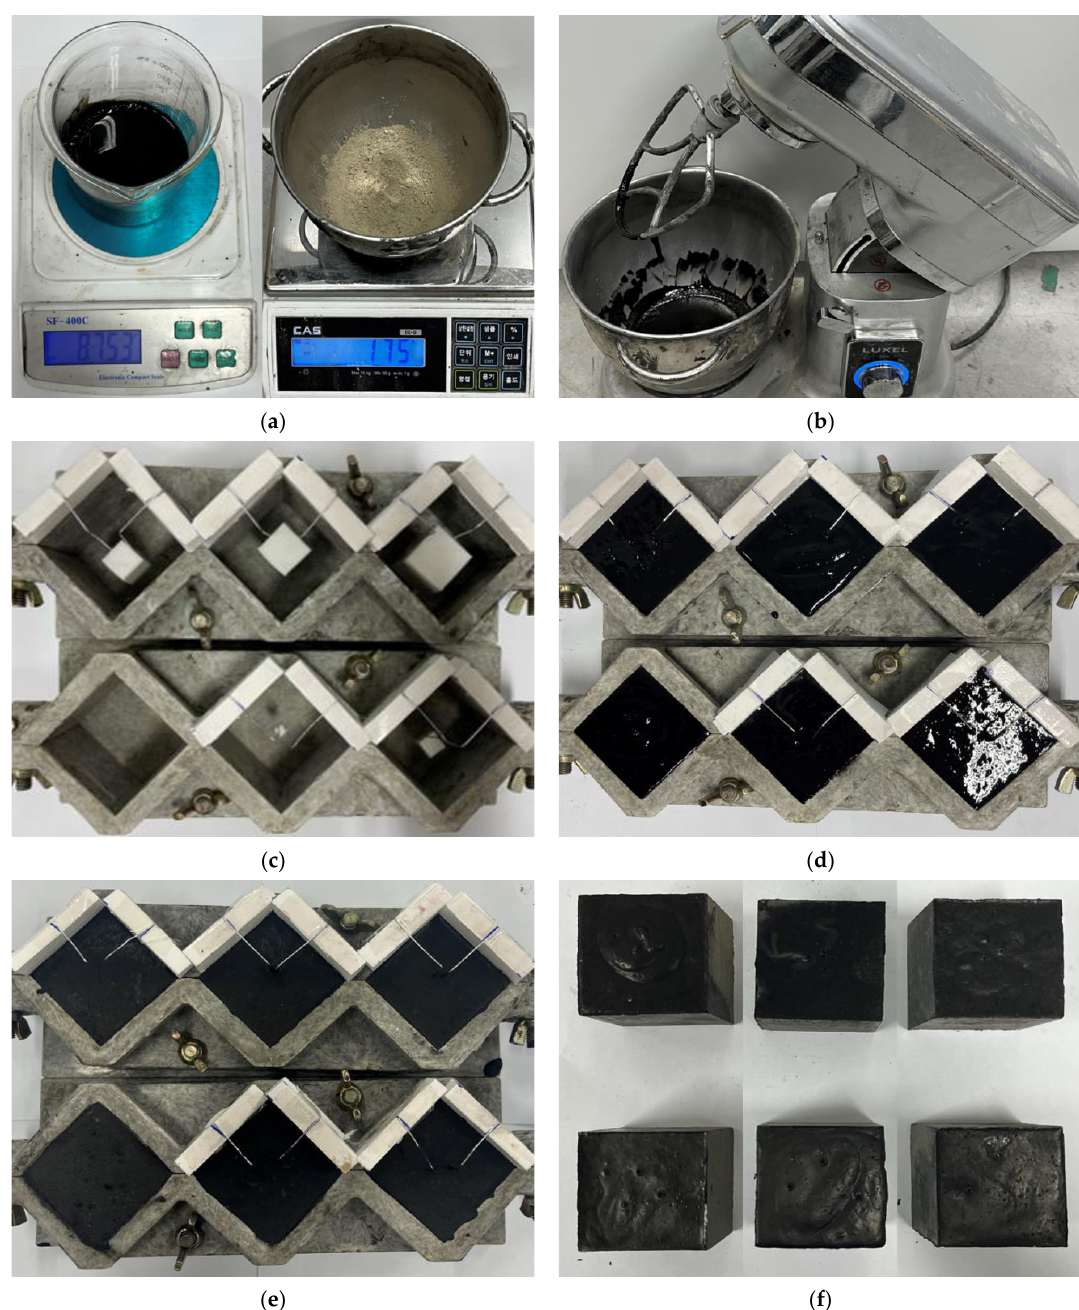
Figure 2. The fabrication process of nano-cementitious composites: ( a ) Measuring the material; ( b ) mixing; ( c ) implementing defects; ( d ) pouring paste in a mold; ( e ) curing on standard conditions; ( f ) specimens with a defect.